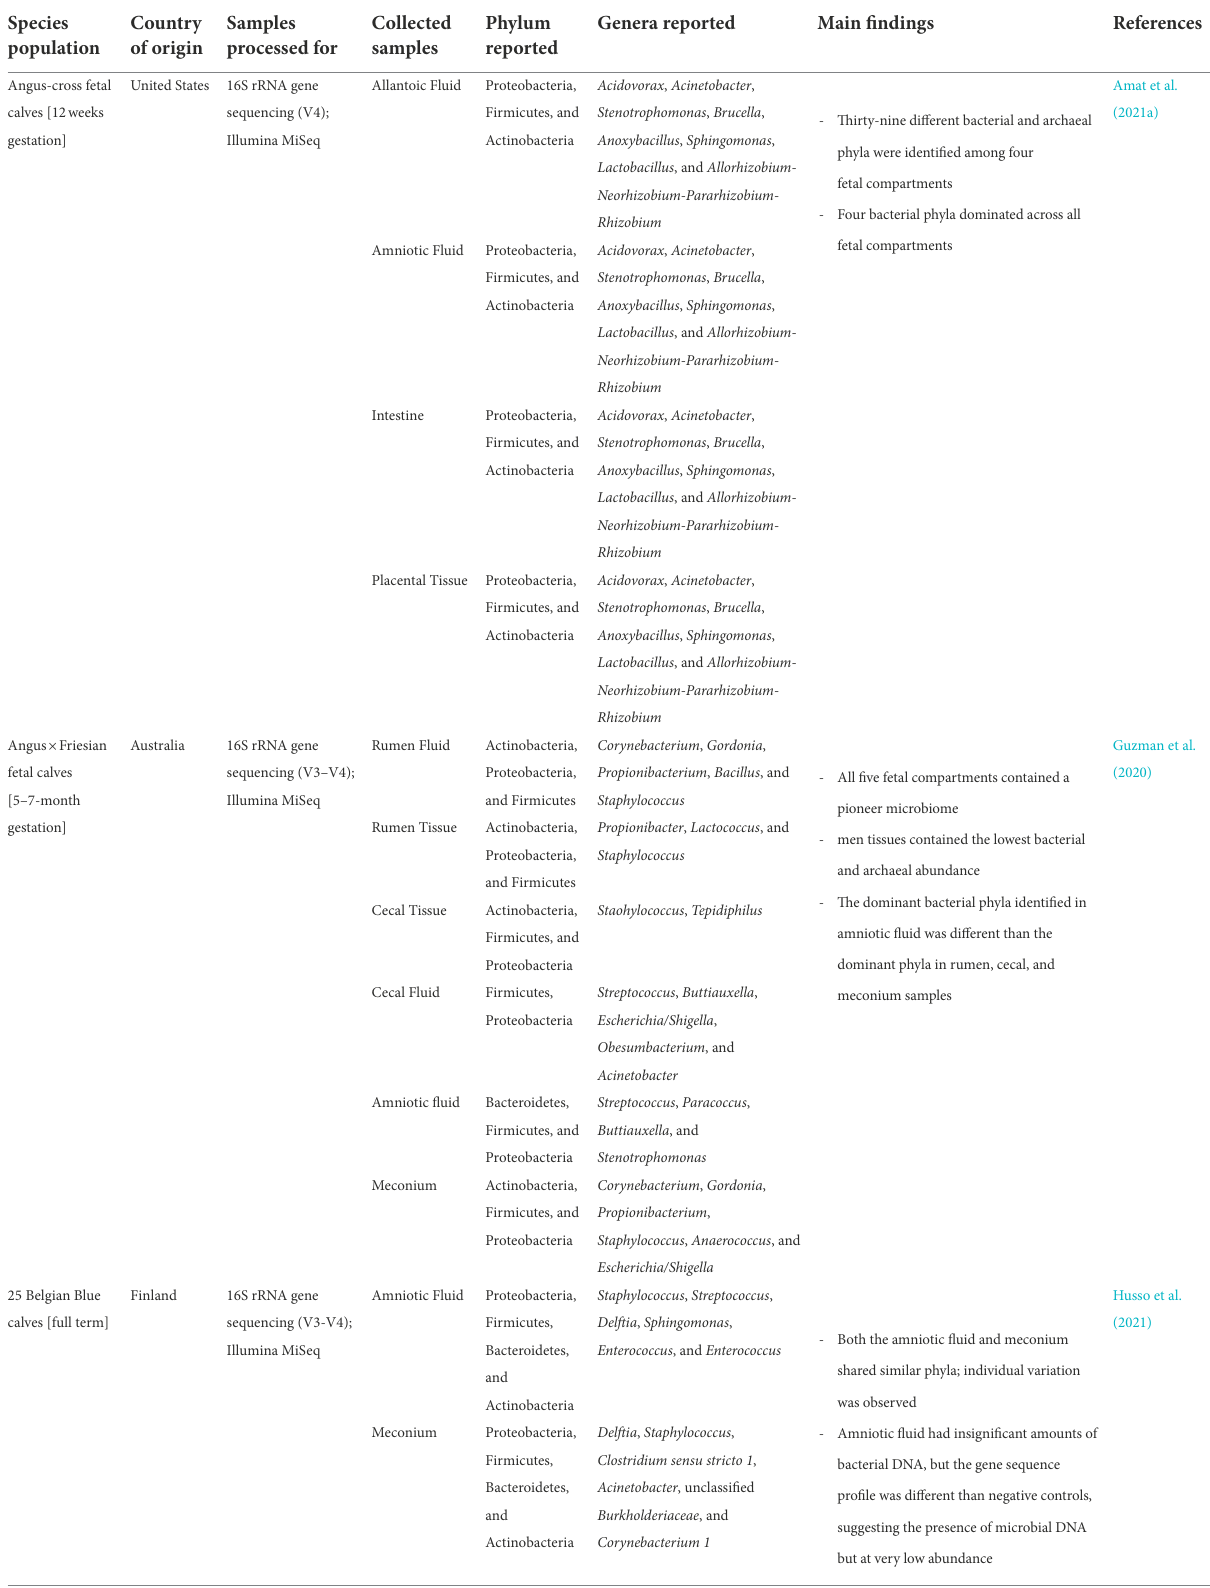
TABLE 3 Taxonomic identification of fetal-associated microbiota from several recent high-throughput sequencing-based